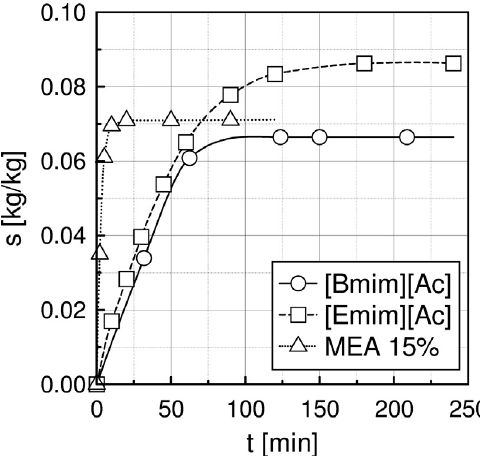
Figure 1. The CO 2 sorption capacity at 1 bar, temperature 40 °C, gas flow rate V g = 36 L/h. At the temperature of 40 °C, atmospheric pressure and gas flow rate V g = 36 L/h, the CO 2 absorption capacities for [Bmim][Ac] and [Emim][Ac] were 0.067 and 0.086 [kg CO2 /kg IL ] respectively. In the same conditions, the absorption capacity for 15% wt. MEA was close to these values, 0.071 [kg CO2 /kg MEA ]. Similar results were reported in the litera- ture (0.077 and 0.079 for [Bmim][Ac] and [Emim][Ac], respectively) [45]. Additionally, it can be seen in Figure 1 that the absorption profile for MEA is steeper than for IL, which indicates that the CO 2 absorption rate in MEA is higher than in both ILs. The obtained comparable results of CO 2 absorption capacity in selected ionic liquids and MEA solutions led to an attempt to use these ionic liquids as CO 2 absorbents in a packed column. The experimental setup described in [100] consisted of a packed glass column with an inner diameter of 0.05 m, a length of 0.35 m filled with glass Rashig rings of a diameter 5 × 1 mm and a length of 5 mm. The column was heated with a water jacket. The ionic liquid or MEA solution flowed through the bed and absorbed CO 2 from the gas mixture in co-current or countercurrent flow. The experiments were carried out at atmos- pheric pressure and in temperatures of 20, 40 and 60 °C. The CO 2 absorption in ILs was performed in a limited range of flow rates to avoid flooding of the column. In the co-current flow (gas 1–2.3 L/min and liquid 0.05–0.2 L/min) and in the countercurrent flow (gas 1–2.1 L/min and liquid 0.05–0.1 L/min). The absorp- tion temperature determines the efficiency of CO 2 capture. The minimum absorption tem- perature was set at 40 °C because [Bmim][Ac] solidifies at 30 °C. The regeneration step (desorption process) was carried out at the temperature 90 °C, using pure nitrogen to help stripping CO 2 . The regenerated IL was used again. In the case of MEA, for each experiment, new 15 wt.% MEA-water solution was used. The amount of absorbed CO 2 in the absorption process (3–4 h) and amount of desorbed CO 2 in desorption